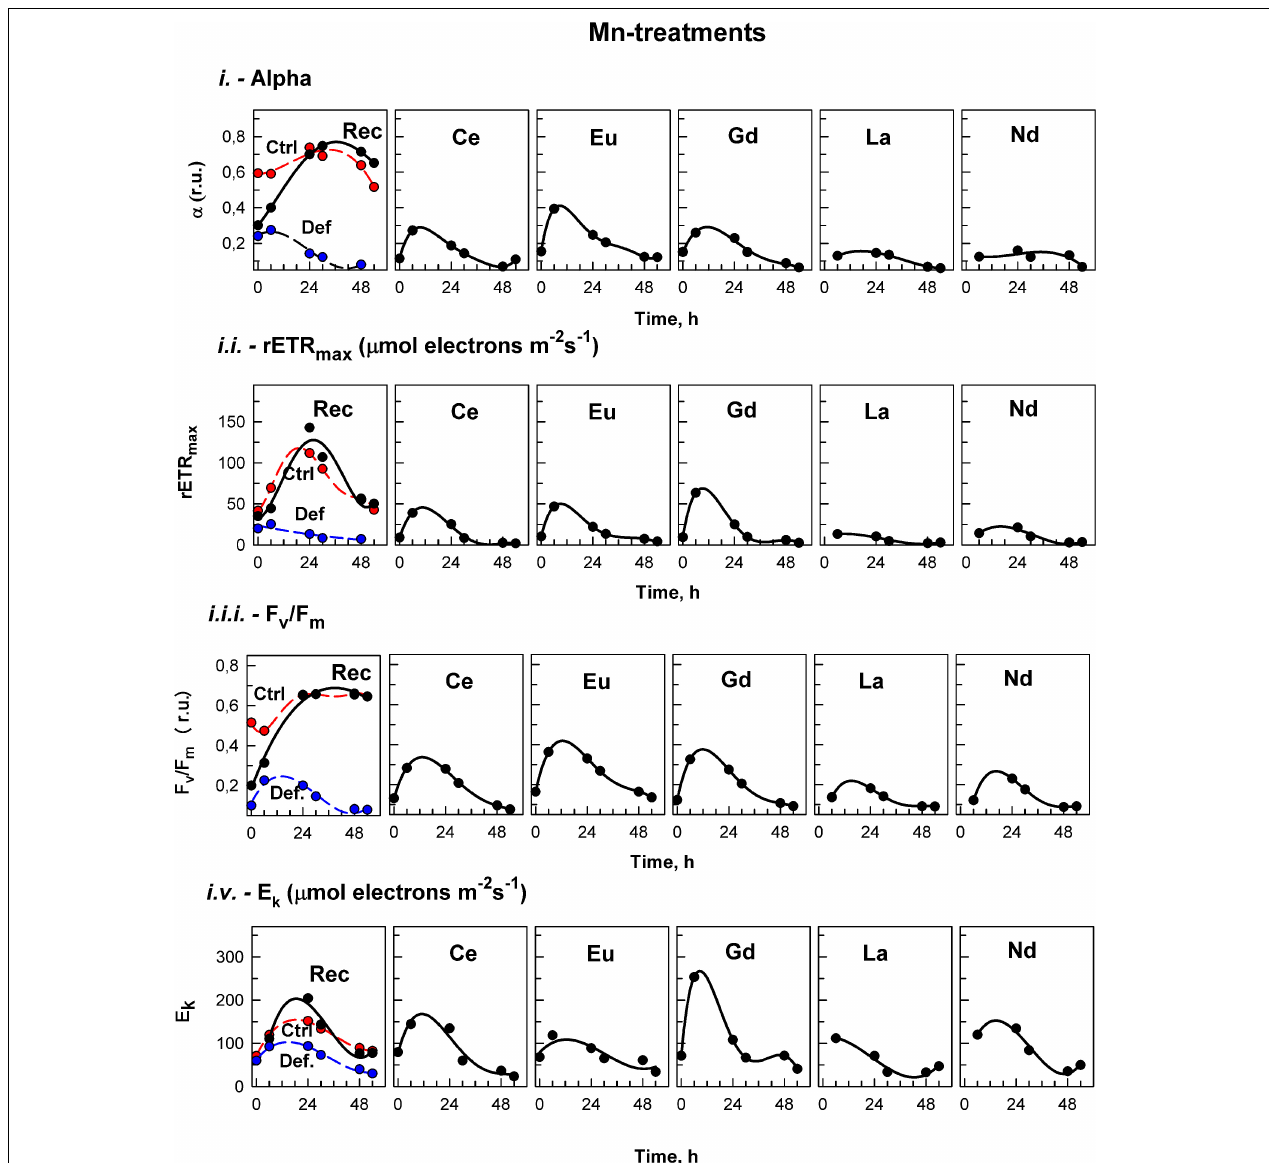
FIGURE 4 | Manganese treatment. The photosynthetic parameters in cultures of the alga Desmodesmus quadricauda grown either in complete mineral medium (Ctrl, red symbols, dashed curve) or in manganese- deficient mineral medium (Def blue symbols, dashed curves) are shown. To manganese deficient cultures either the complete mineral medium was added (Rec, black symbols, solid line)